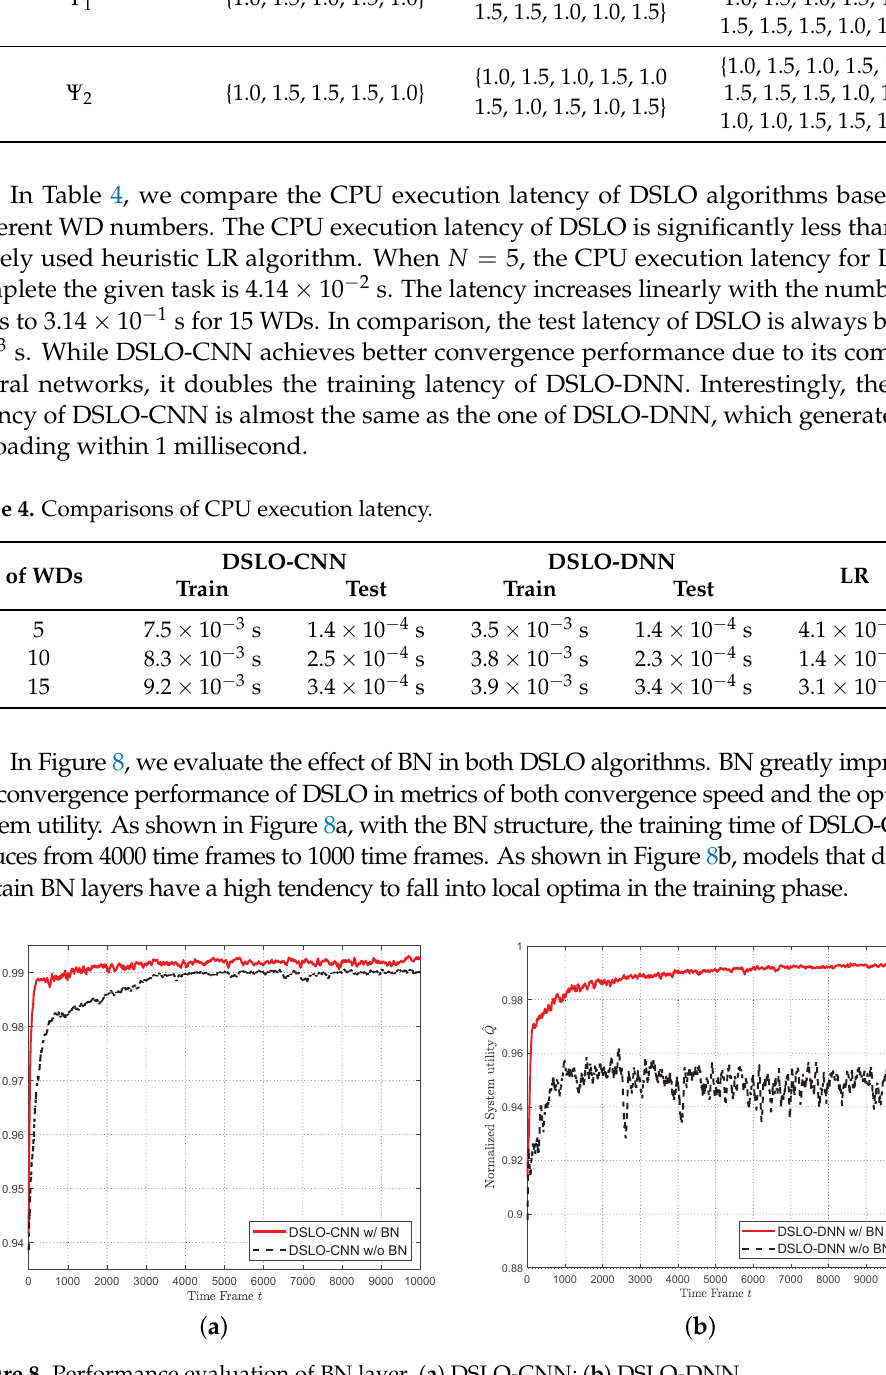
Figure 8. Performance evaluation of BN layer. ( a ) DSLO-CNN; ( b )